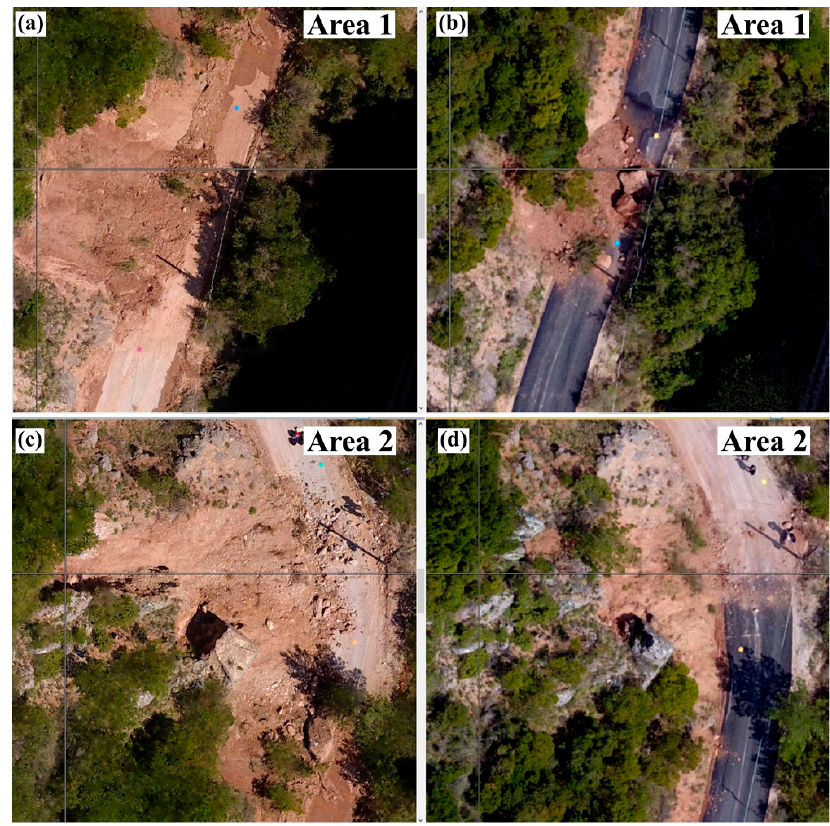
Figure 8. Orthophotos: ( a ) Area 1 on 11 April 2020, ( b ) Area 1 on 21 April 2019, ( c ) Area 2 on